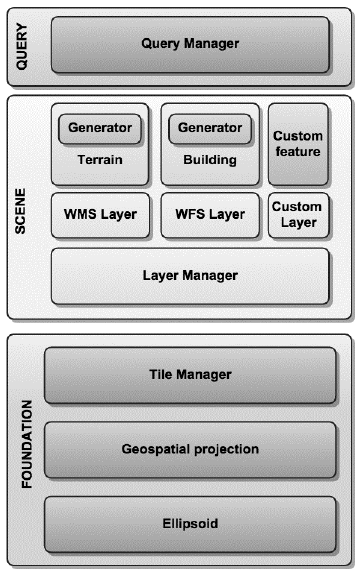
Figure 1. Framework architecture with implemented layers